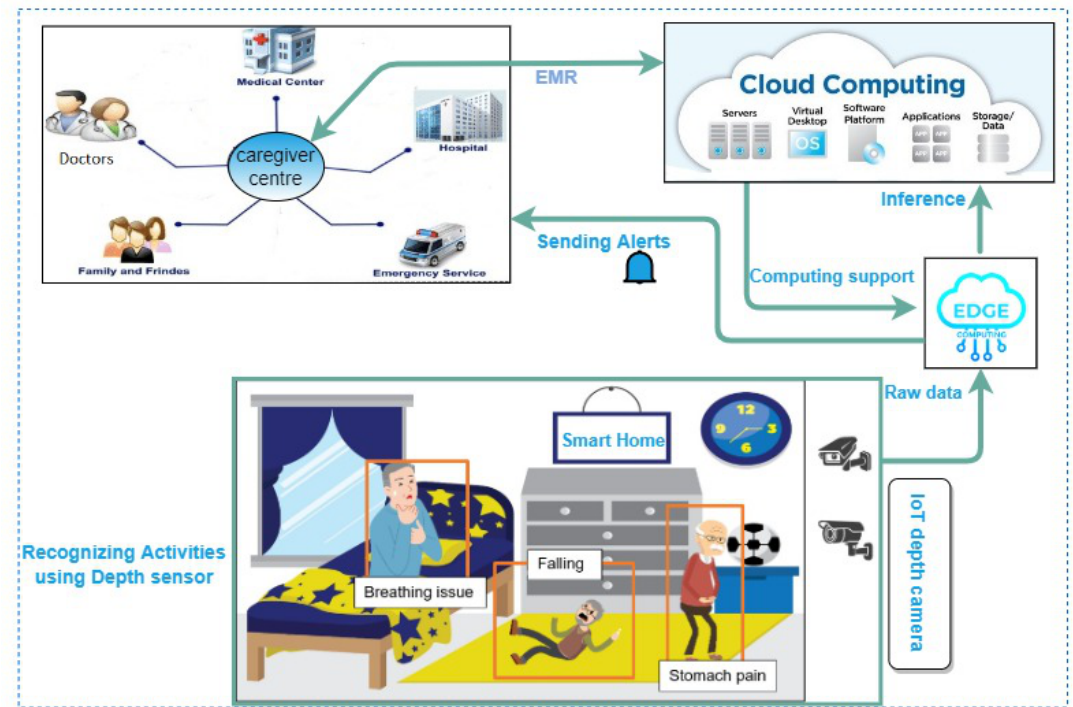
Figure 1. A working overview of a smart home for senior